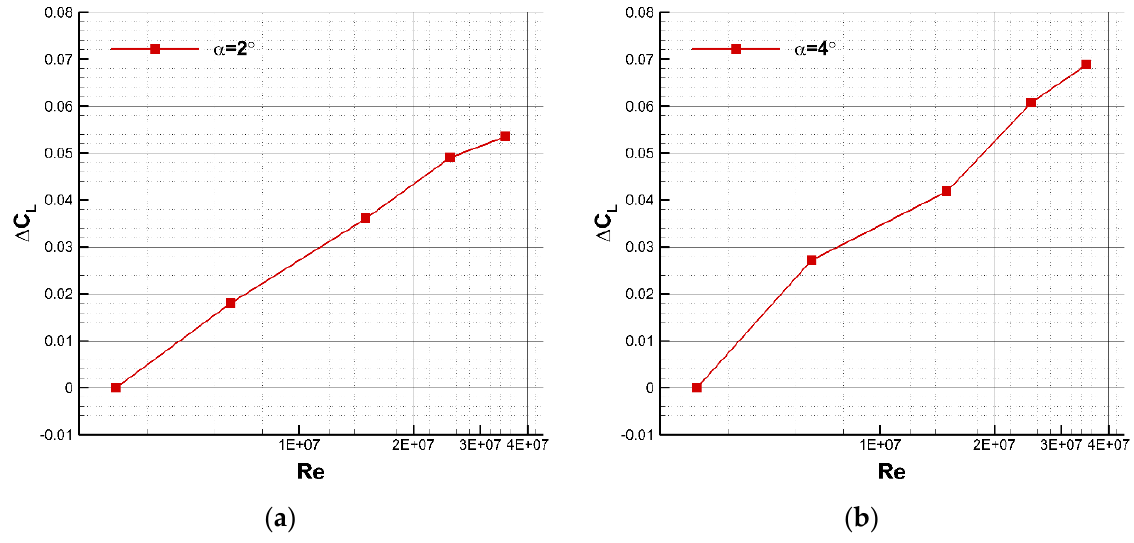
Figure 19. Increments of lift coefficient versus Reynolds number (M = 0.76): ( a ) α = 2°; ( b ) α = 4°.